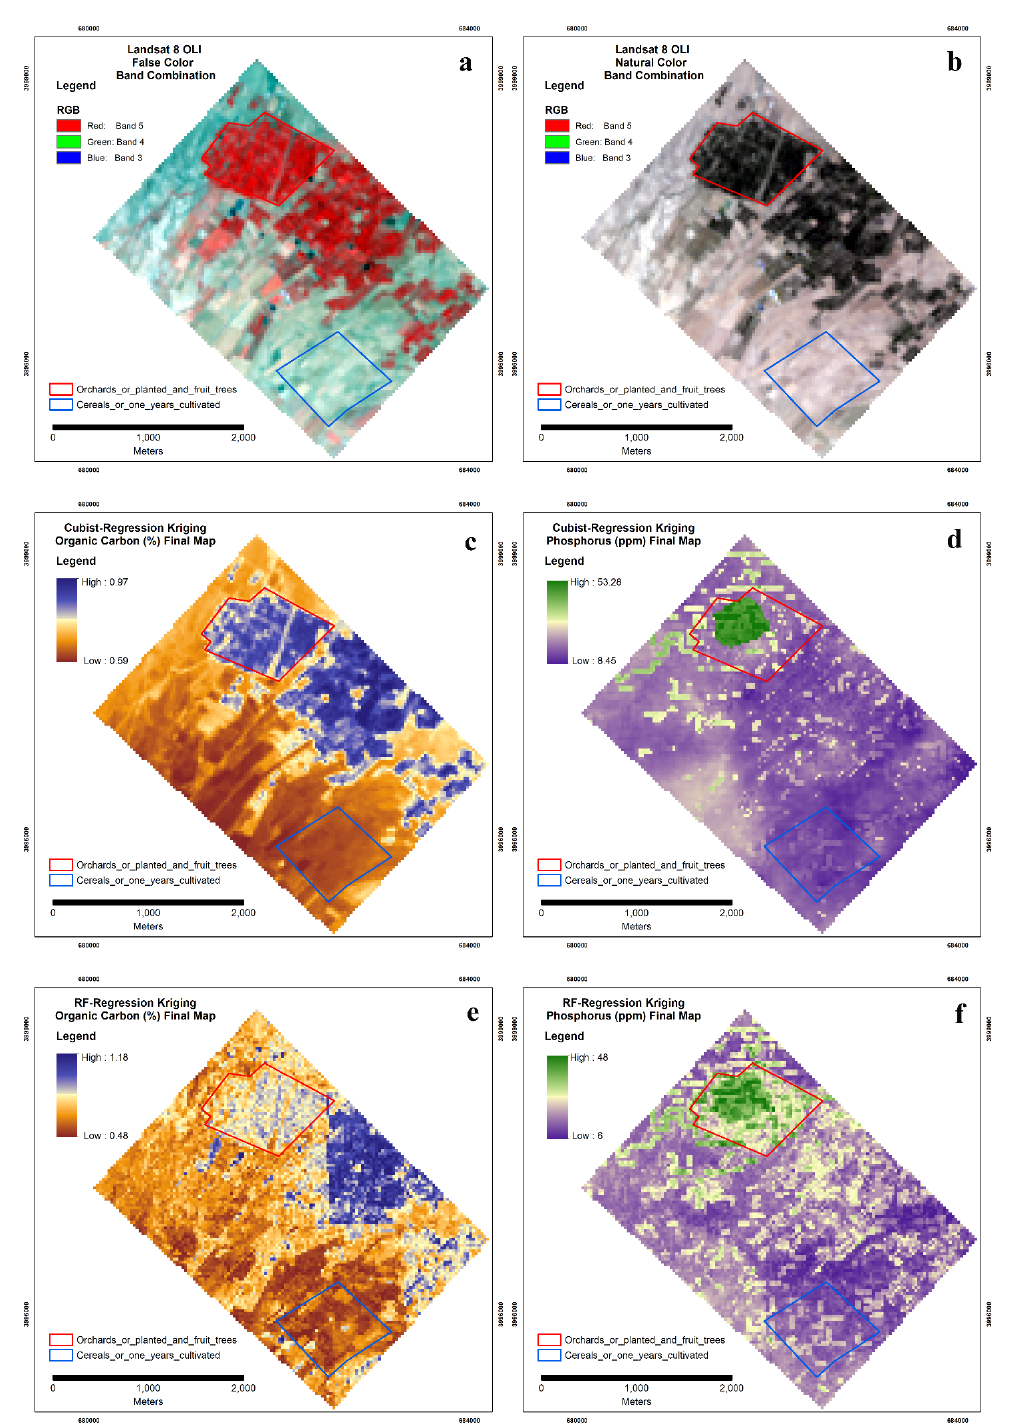
Figure 9. Estimated SOC and phosphorus of hybrid technique by two methods ( a ): Display of different land uses on Landsat 8 OLI image (False color band combination); ( b ): Display of different land uses on Landsat 8 OLI image (Natural color band combination); ( c ): Spatial distribution of organic carbon in land uses estimated by Cubist-RK; ( d ): Spatial distribution of available phosphorus in land uses estimated by Cubist-RK; ( e ): Spatial distribution of organic carbon in land uses estimated by RFRK; ( f ): Spatial distribution of available phosphorus in land uses estimated by